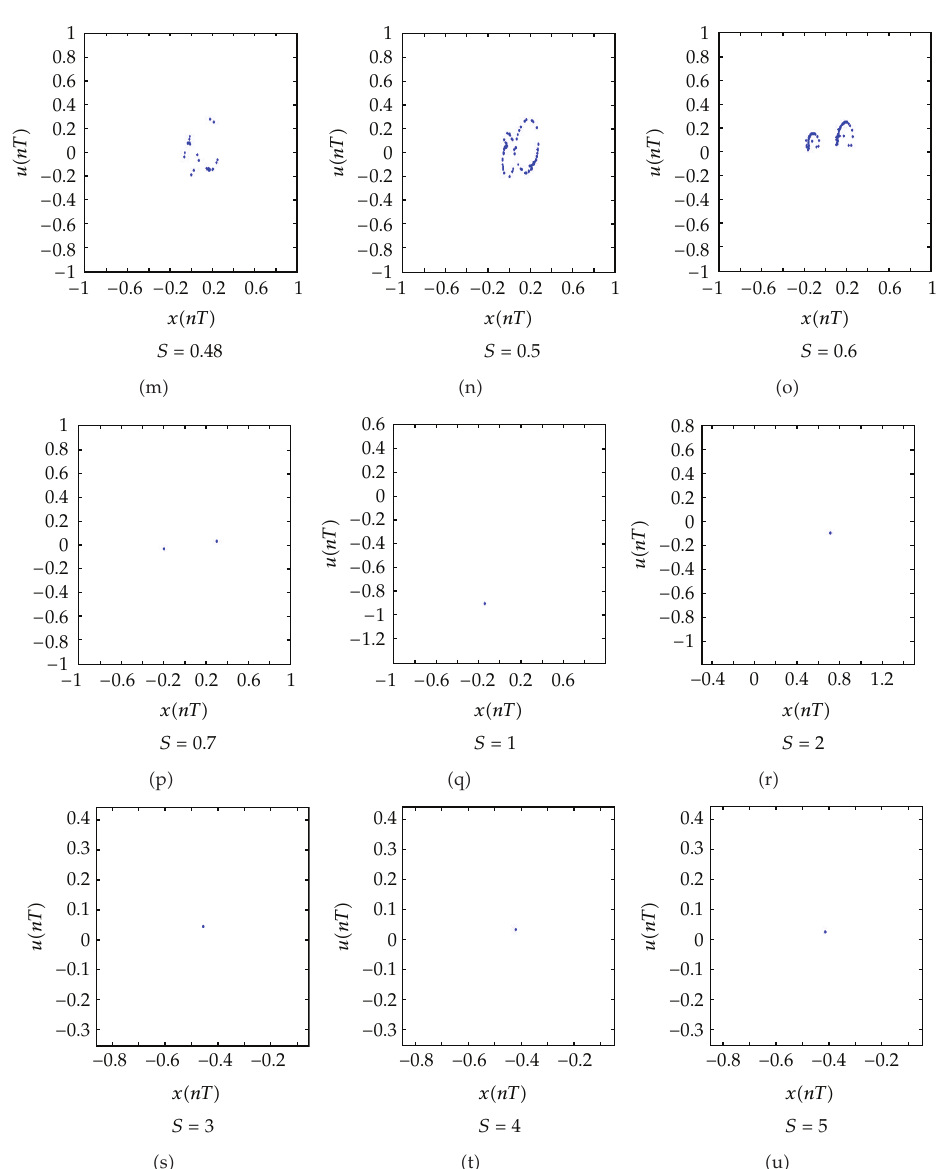
Figure 11: Poincar´e maps for the route of subharmonic motion into chaos, out of chaos to periodic response at di ff erent rotating speed ratios of s (cid:2) with rub-impact e ff ect (cid:3) .